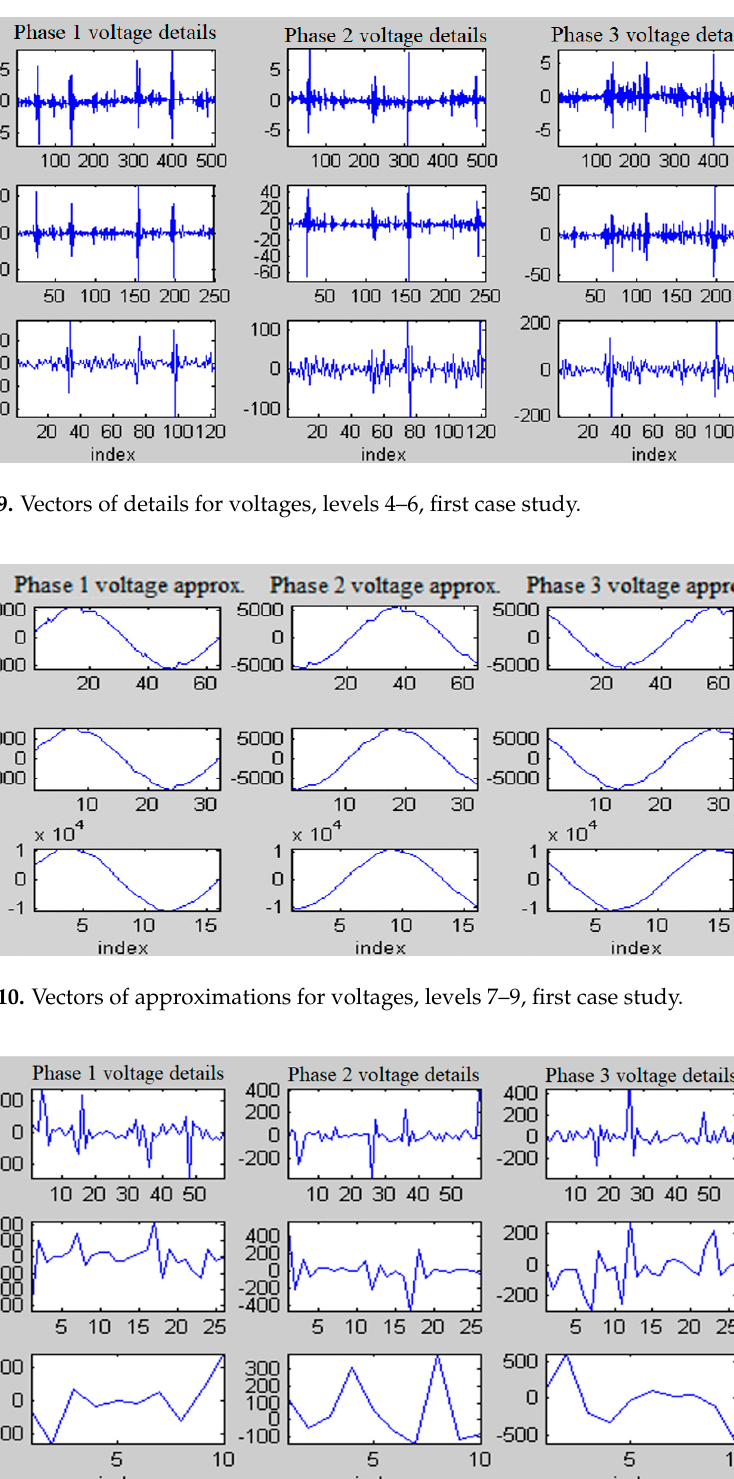
Figure 8. Vectors of approximations for voltages, levels 1–3, first case study.